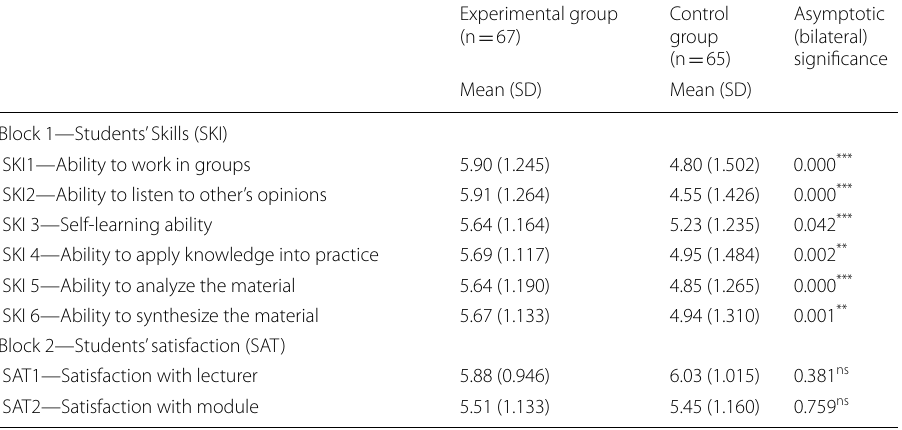
Table 6 The Mann–Whitney U test comparing the experimental group with the control group